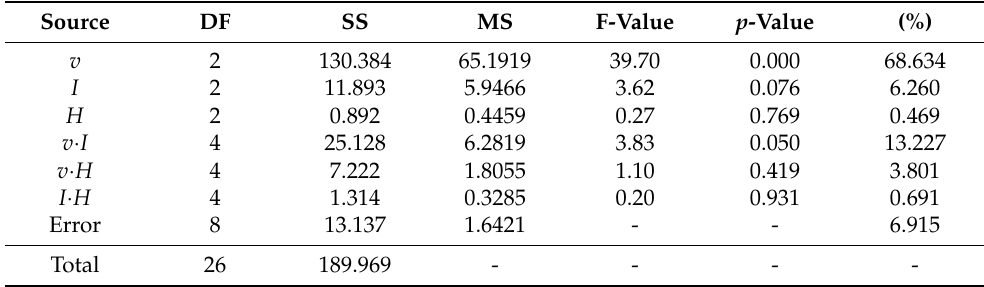
Figure 11 . Experimental surface roughness Rz vs. predicted surface roughness Rz . Figure 11. Experimental surface roughness Rz vs. predicted surface roughness Rz . Table 9. ANOVA for surface roughness Rz. Table 9. ANOVA for surface roughness Rz .